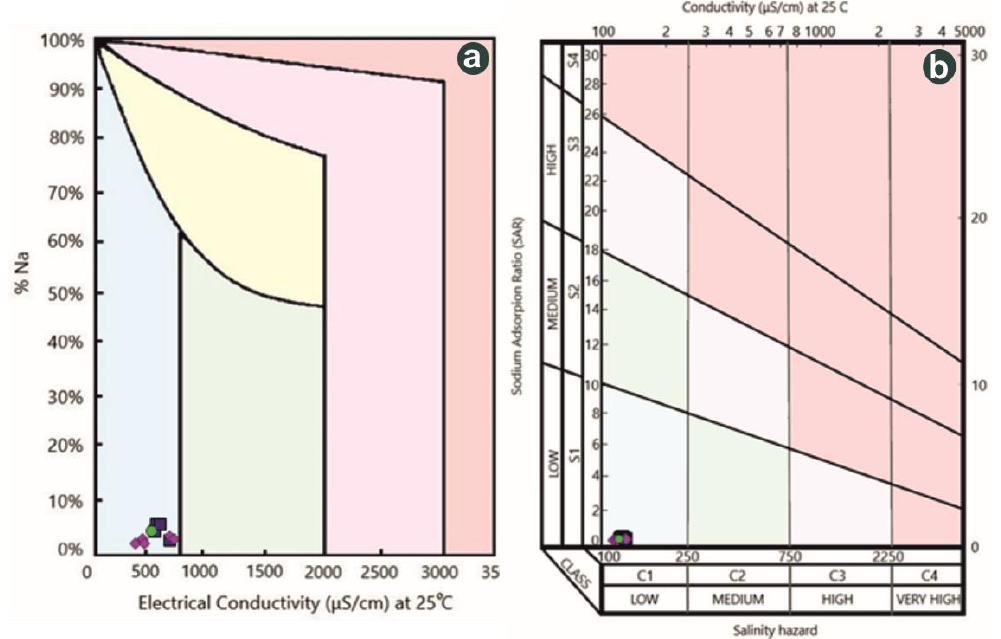
Figure 3. ( a ) Wilcox and ( b ) Richards diagrams. Table 2. Statistics of the parameters rank utilized to compute Groundwater Quality Index